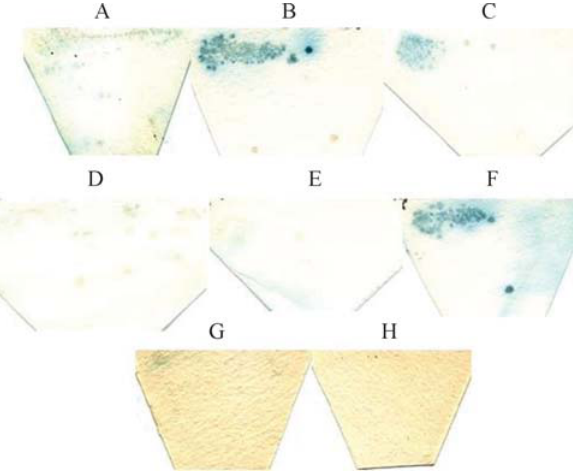
Figure 3 - Two-hybrid X-gal filter assay. Transformant Y190/pGAD424 ( A ; original plasmid) was used as negative control while transformant Y190/pVA3/pTD1 ( B ; GAL4-BD-p53 / GAL4-AD-sv40 large T antigen ) was used as positive control for protein-protein interaction. Y190/pADA-3 ( C ; GAL4-AD-matA-3 ) and Y190/pADA-2 ( D ; GAL4- AD-mat A-2 ) were used as negative controls for transcriptional activation. These transformants were grown on SD media lacking leucine while Y190/pVA3/pTD1, Y190/pBDA-2 ( GAL4-BD-matA-2 )/pADA-2 ( E ), Y190/pBDA-3 ( GAL4-BD-mat A-3 )/pADA-2 ( F ), Y190/pBDA- 3/pADA-3 ( G ) and Y190/ pBDA-2/pADA-3 ( H ) were grown on SD me- dia lacking both tryptophan and leucine.